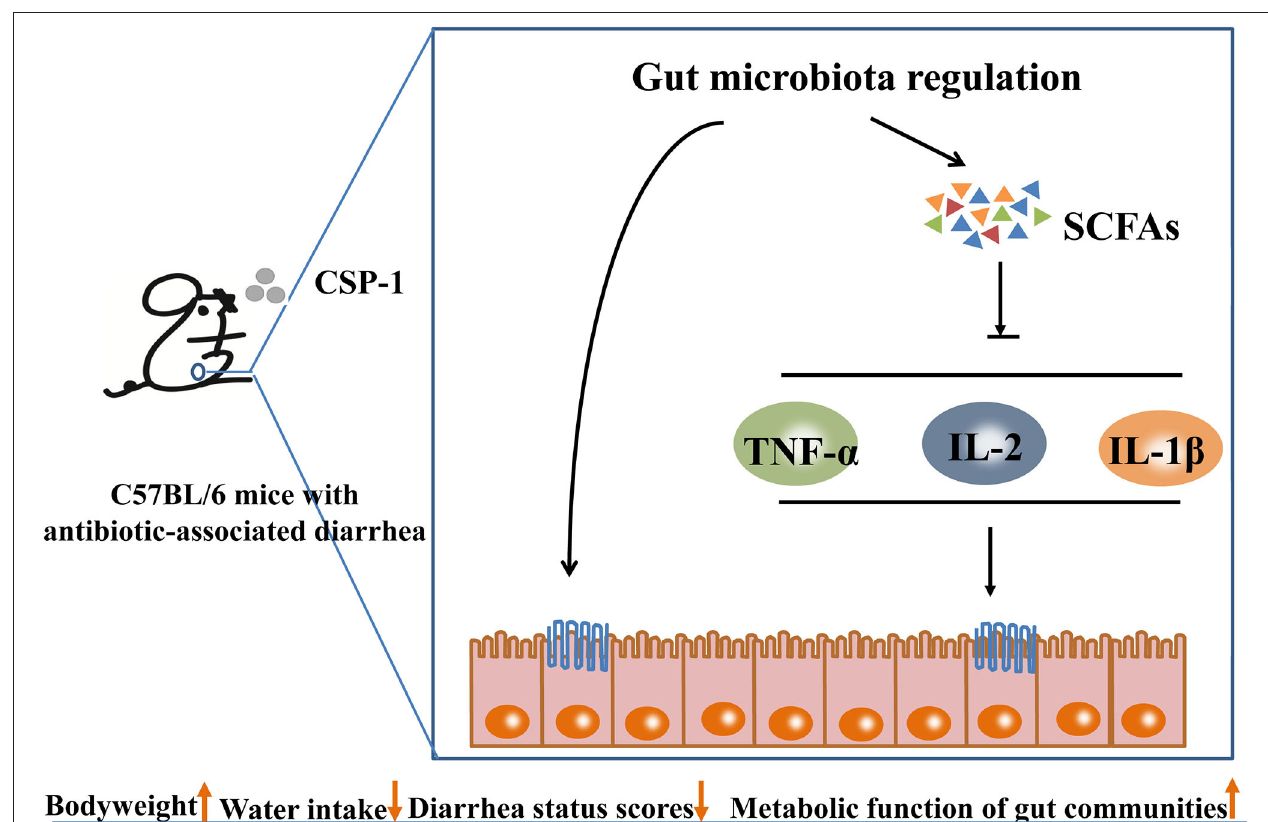
FIGURE 8 | Schematic diagram of the mechanisms of CSP-1 alleviating